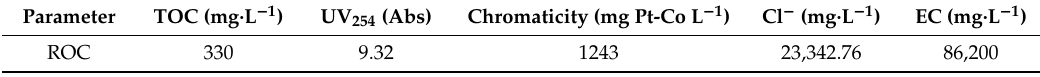
Table 2. Coal chemical reverse osmosis concentrate (ROC)